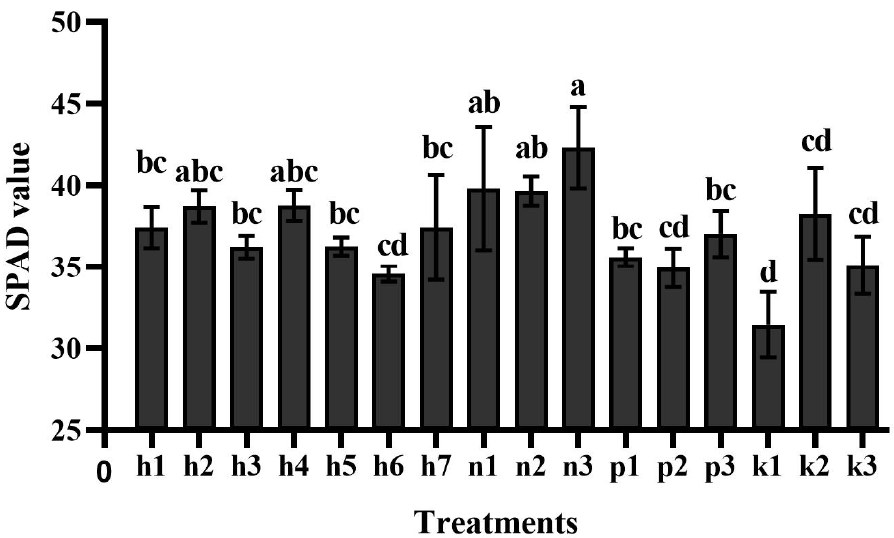
Figure 2. Light distribution characteristics of different fertilization treatments. ( a ) Leaf canopies’ structure and light distribution during individual growth period of jujube. Numerical values repre- sent light intensity. ( b ) Leaf canopies’ structure and light distribution during individual growth period of interrow jujube. ( c ) Different fertilization treatments and jujube tree interior canopy light intensity (ICLI). (mean ± SD, n = 12). ( d ) Different fertilization treatments and jujube tree external canopy light intensity (ECLI) (mean ± SD , n = 12). Mean totals with a common letter are not different ( p < 0.05) by ANOVA for the ranking test.